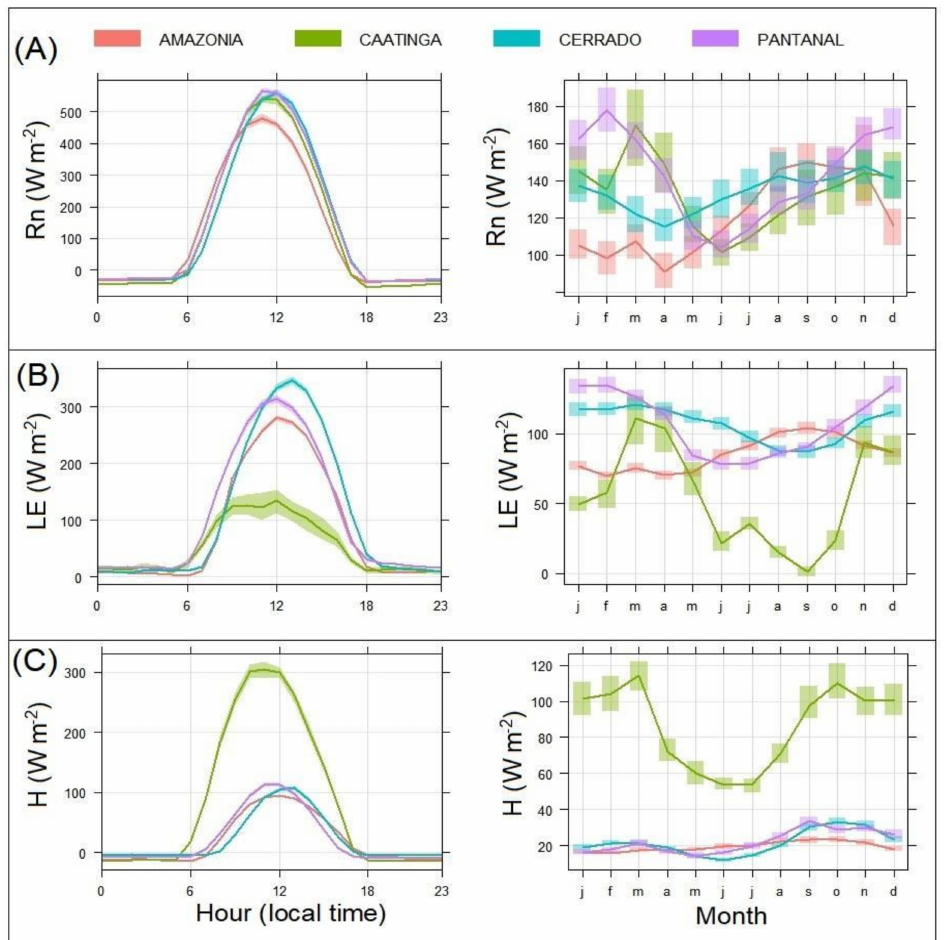
Figure 6. Hourly and monthly variation of energy fluxes: ( A ) net radiation (Rn, W m − 2 ), ( B ) latent heat flux (LE, W m − 2 ) and ( C ) sensible heat flux (H, W m − 2